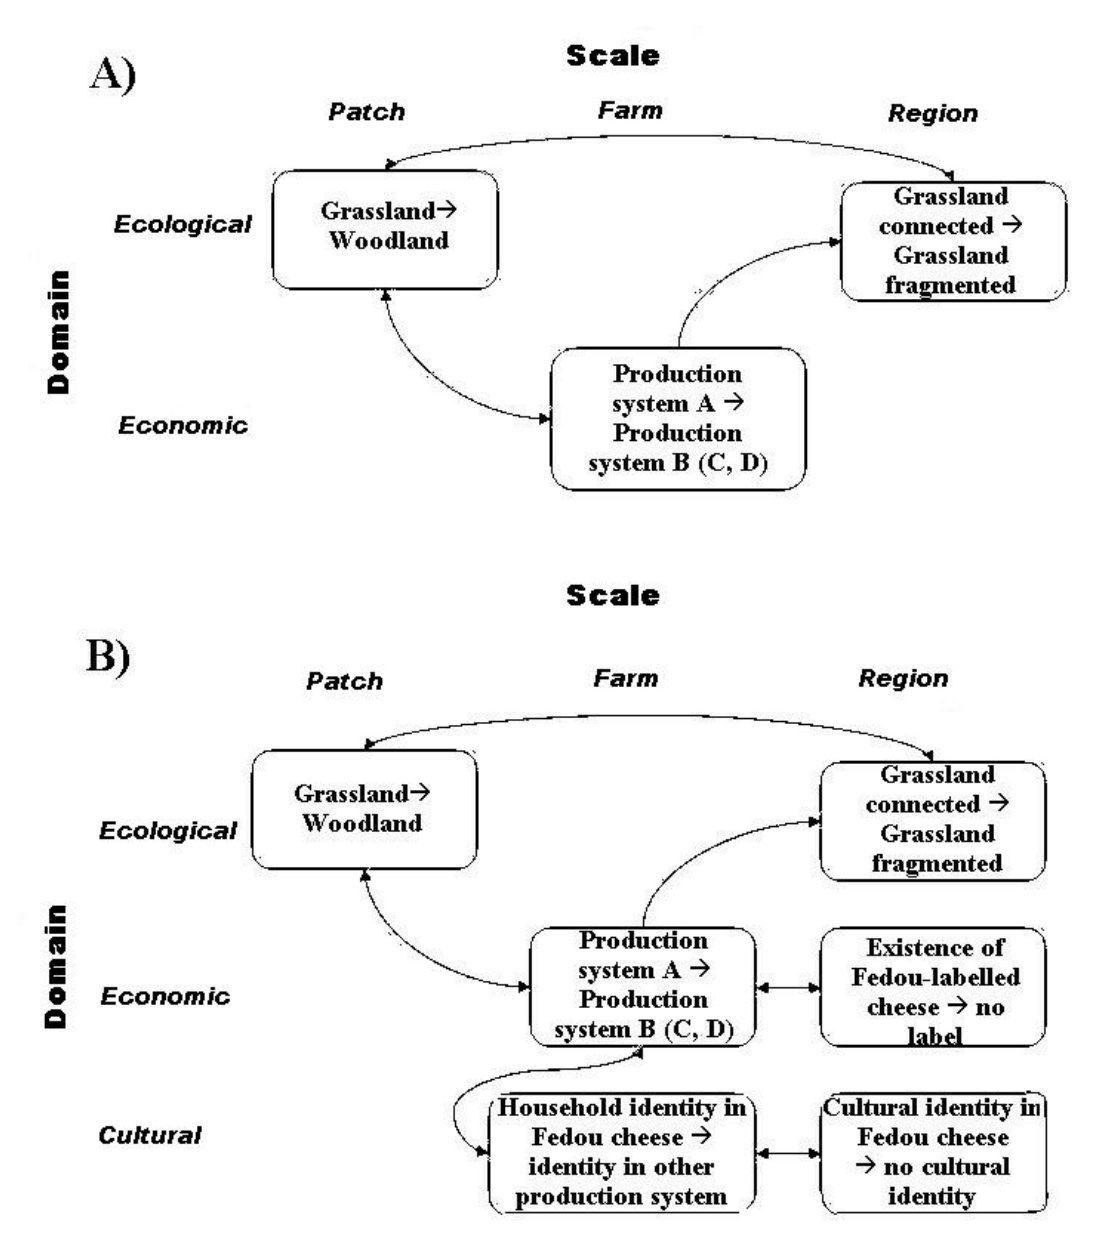
Fig. 3 . Interactions among regime shifts in the Causse Méjan case study. A is a partial assessment, and B is the complete assessment (see text). The boxes represent potential thresholds in various domains, e.g., ecological vs. economic, at various scales. For instance, when grazing pressure is low, there is a threshold of pine seed rain that, once crossed, prevents mechanical clearing of seedlings and leads to a regime shift from grassland to woodland at the patch scale. The arrows between boxes show interactions among thresholds (see